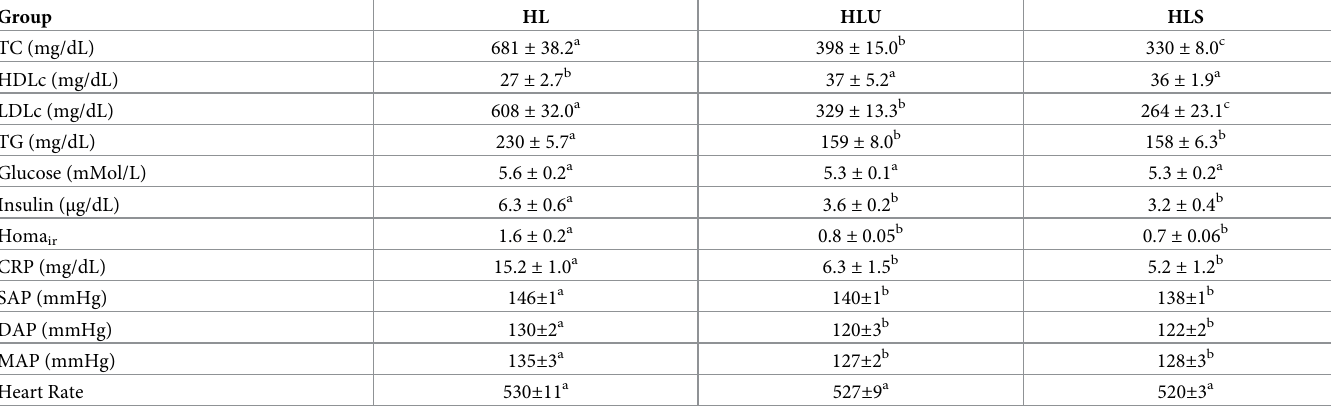
Table 1. Comparison of serum levels of lipids, glucose, insulin, Homa index (Homair), CRP and systolic blood pressure (SAP), diastolic blood pressure (DAP), mean arterial pressure (MAP) and LDLr -/- heart rate mice from the HL, HLU and HLS groups. Group HL HLU HLS TC (mg/dL) HDLc (mg/dL) LDLc (mg/dL) TG (mg/dL) Glucose (mMol/L) Insulin ( μ g/dL) Homa ir 1.6 ± 0.2 a CRP (mg/dL) SAP (mmHg) 146 ± 1 a 140 ± 1 b 138 ± 1 b DAP (mmHg) MAP (mmHg) 135 ± 3 a 127 ± 2 b 128 ± 3 b Heart Rate 530 ± 11 a 527 ± 9 a 520 ± 3 a Values expressed as mean ± standard error of the mean. Different letters indicate significant differences between groups for each variable (p < 0.05). Total cholesterol (TC); high density lipoprotein cholesterol (HDLc); low density lipoprotein cholesterol (LDLc); triglycerides (TG) and C-reactive protein (CRP). HL Group: The mice received a high fat diet with 20% total fat, 1.25% cholesterol and 0.5% cholic acid; HLU Group: The mice received a high fat diet with 20% total fat, 1.25% cholesterol, 0.5% cholic acid and treated with grape juice; HLS Group: The mice received a hyperlipidemic diet with 20% total fat, 1.25% cholesterol, 0.5% cholic acid and treatment with